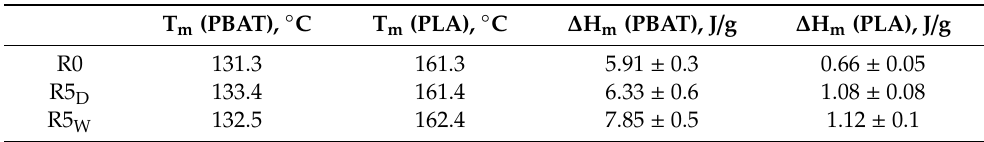
Table 3. Melting temperature and enthalpy of fusion of the virgin sample and of the samples reprocessed 5 times in dry and wet